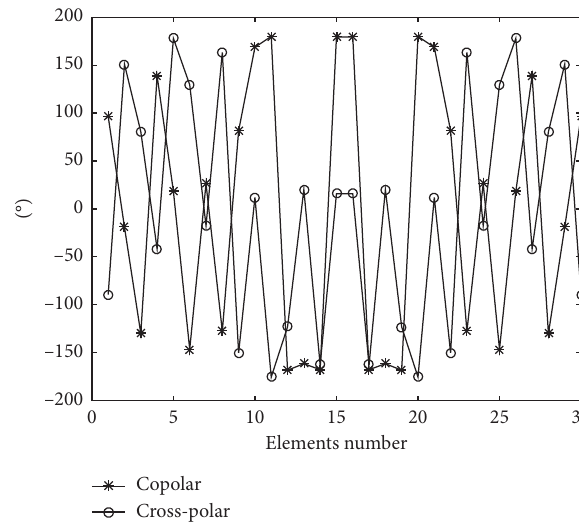
Figure 5: Normalized amplitudes of the elements weights. Figure 6: Phases of the elements weights.